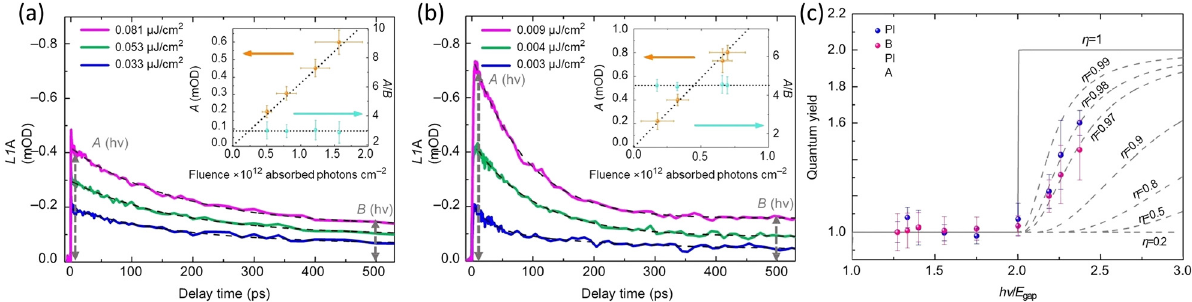
Figure 3: The dynamics of TA are lower than (a) and higher than (b) carrier multiplication threshold, and the dotted line represents the exponential fi ttingof the data. The illustrationshowsthe A / B ratio. (c) The multipleexciton productionef fi cienciesare plottedas a functionof the excitation energy